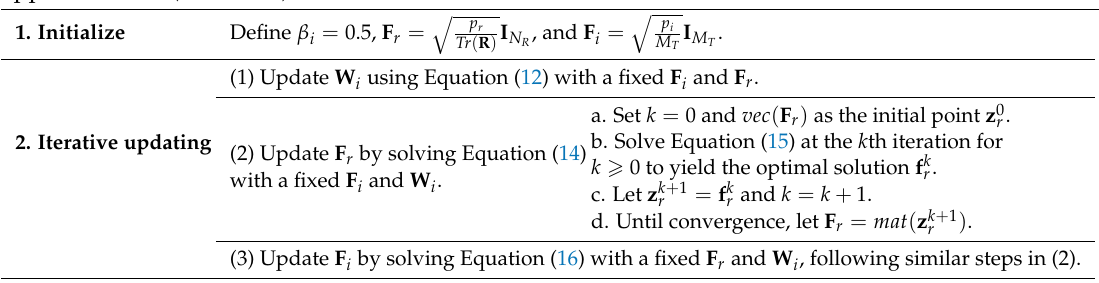
Algorithm 1 An alternating optimization algorithm based on a feasible point pursuit-successive convex approximation